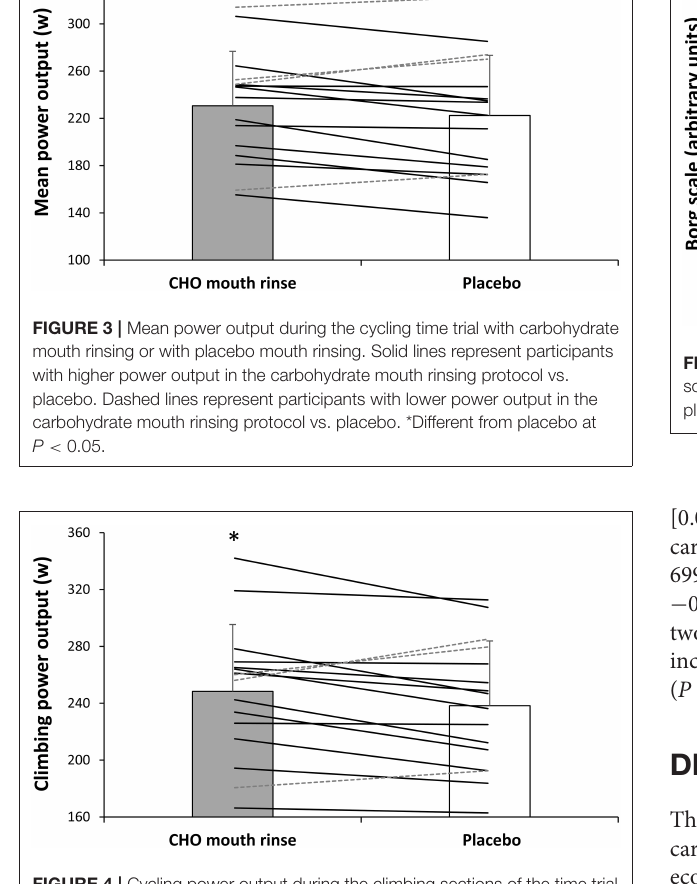
FIGURE 4 | Cycling power output during the climbing sections of the time trial with carbohydrate mouth rinsing or with placebo mouth rinsing. Solid lines represent participants with higher power output in the carbohydrate mouth rinsing protocol vs. placebo. Dashed lines represent participants with lower power output in the carbohydrate mouth rinsing protocol vs. placebo. *Different from placebo at P < 0.05.